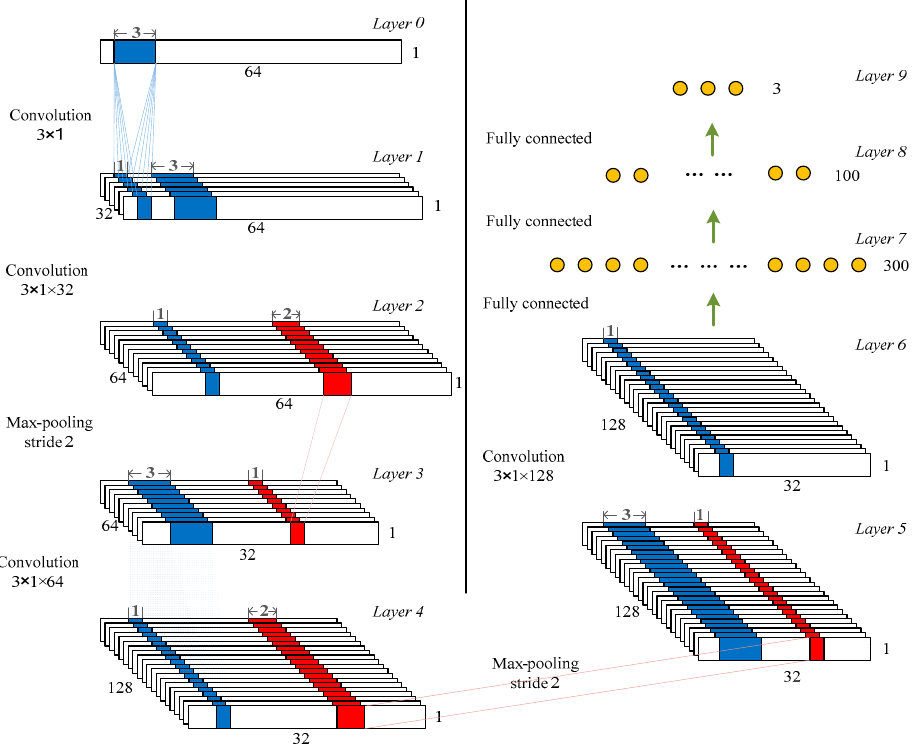
Figure 1. Architecture of the proposed convolutional neural network (CNN) model used in the simulated database. The blue region corresponds to convolutional processes, and the red region represents the pooling. The stride of all convolutional layers was 1.